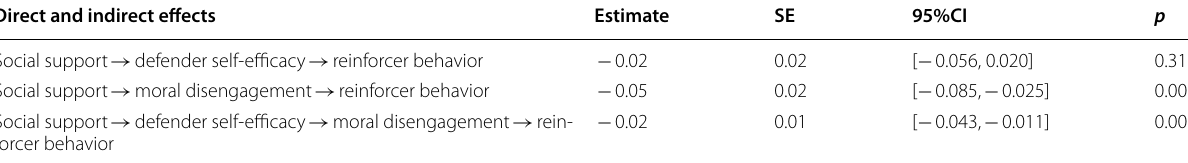
Table 2 Summary of the direct and indirect effects Direct and indirect effects